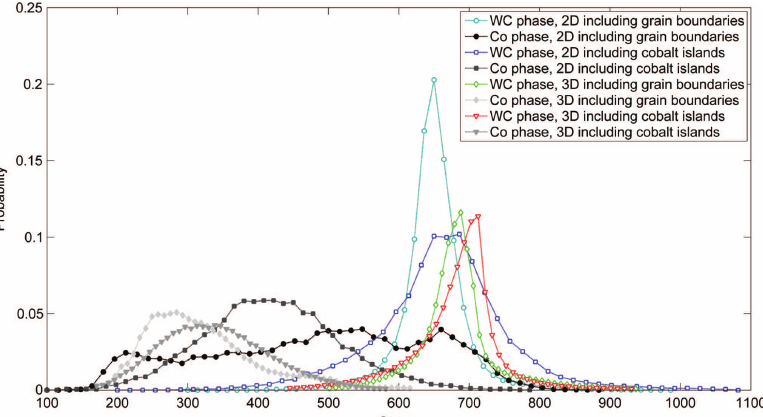
Figure 16: Distributions of the stresses σ 11 in the individual material phases of the material with 6% of cobalt with respect to different modelling approaches.